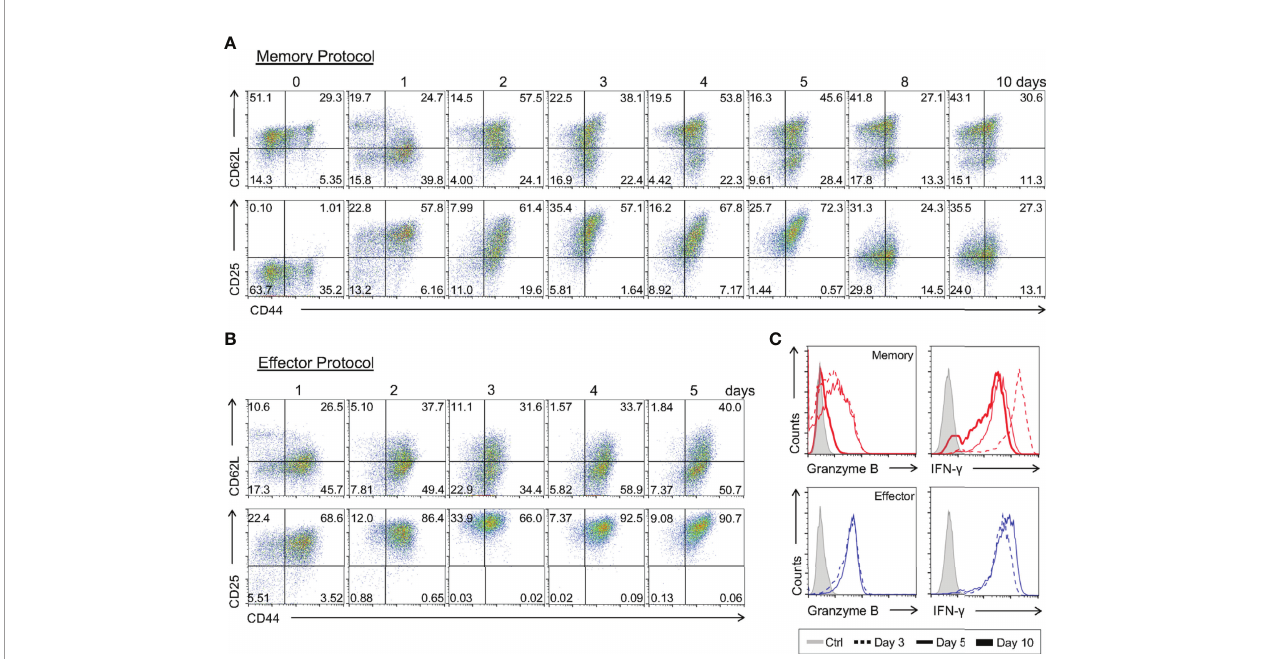
FIGURE 8 | Kinetics of the Immunophenotypic and Functional Pro fi ling of In Vitro- Differentiating Memory and Effector CD8 T Cells. Total CD8 T cells and activated lymphocytes using the memory (A) or effector (B) protocols were stained with anti-CD44, anti-CD62L and anti-CD25 fl uorescently labeled antibodies. (C) Lymphocytes at day 3 (dotted), 5 (thin) and 10 (thick) of culture were challenged with PMA and ionomycin for 6 h and ICC stained for IFN- g and granzyme B quanti fi cation. All results are representative of 3 independent